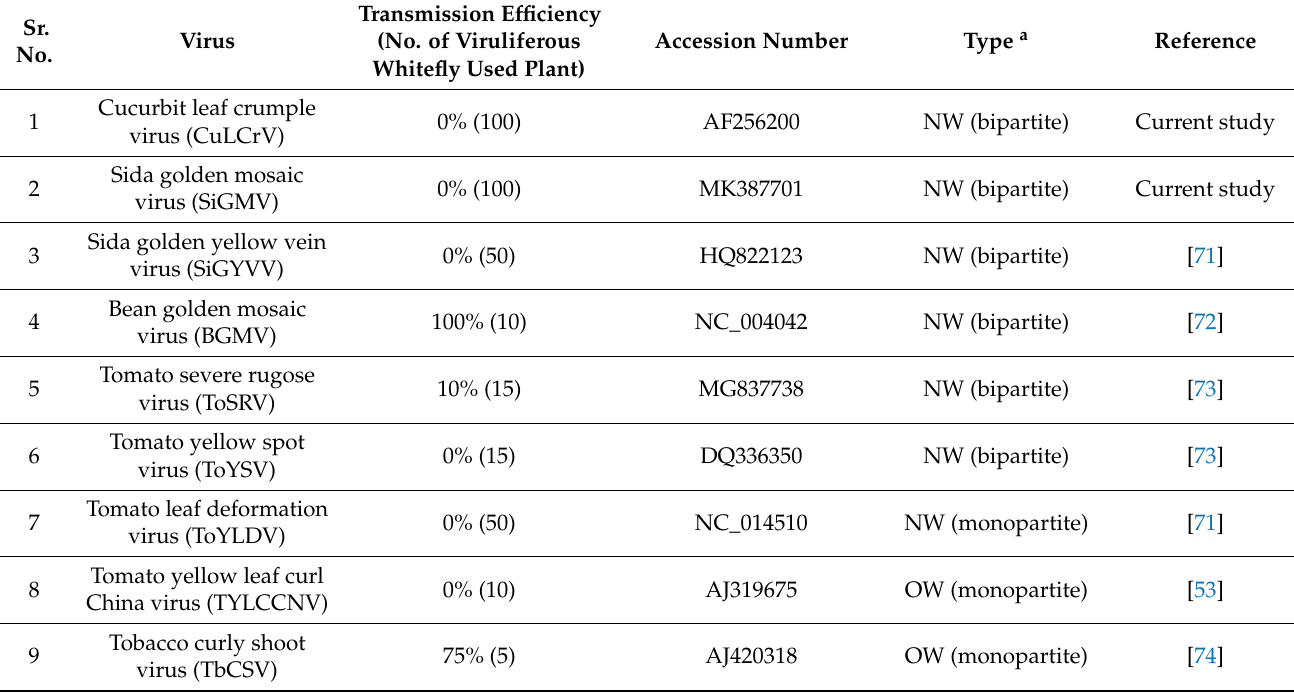
Table 2. Bemisia tabaci MED transmissible and non-transmissible